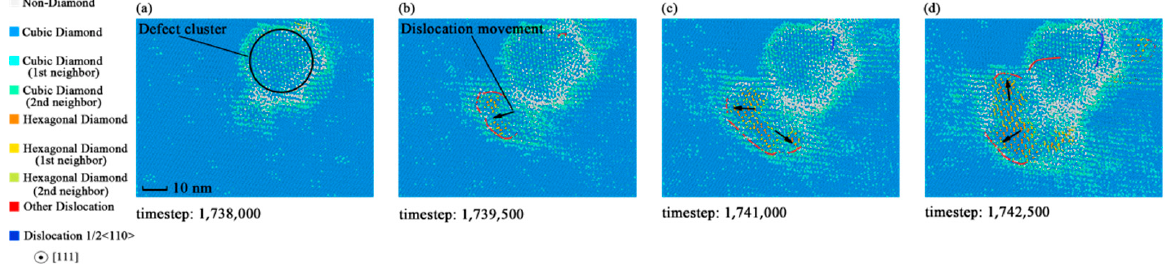
Figure 10. Dynamic behaviors of dislocation in specimen 5 during the process of fracture: ( a ) Dislocation snapshot at timestep 1,738,000; ( b ) dislocation snapshot at timestep 1,739,500; ( c ) dislocation snapshot at timestep 1,741,000; ( d ) dislocation snapshot at timestep 1,742,500.